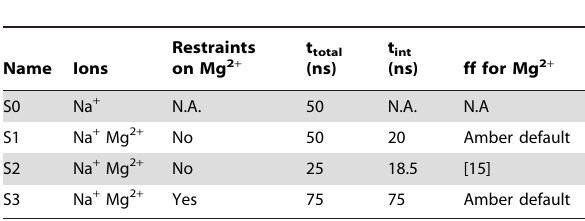
Table 1. MD simulations performed on the Jun-Fos